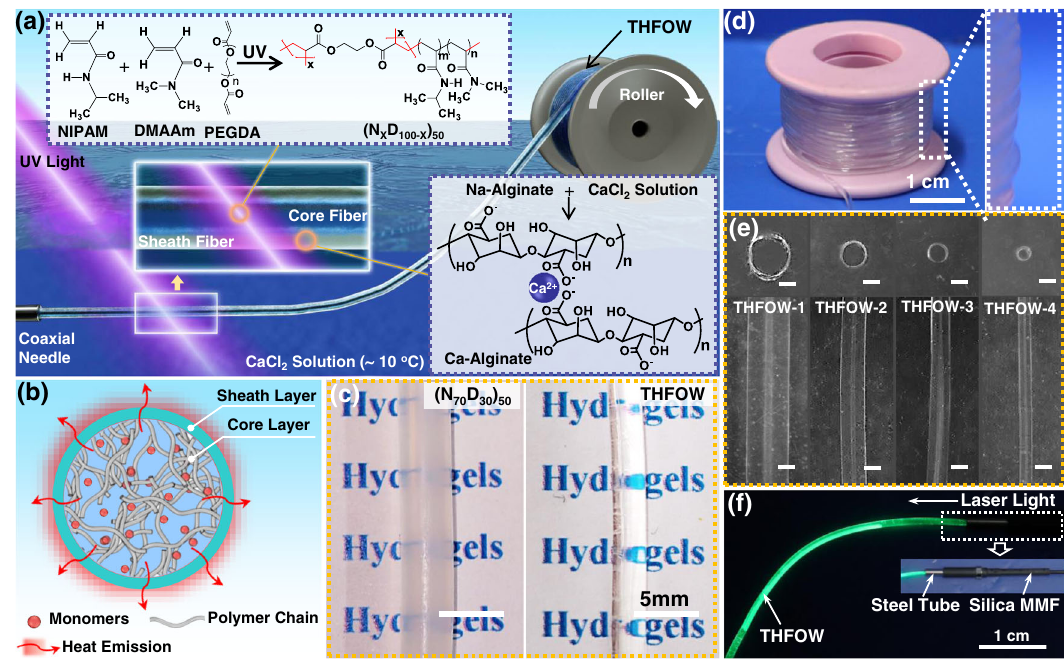
Fig.2|FabricationandcharacterizationoftheTHFOW. Schematicillustrationof ( a ) the fabricating process of the THFOW and ( b ) heat emission from the core monomer precursor; ( c ) Photos of the (N 70 D 30 ) 50 hydrogel and the fabricated